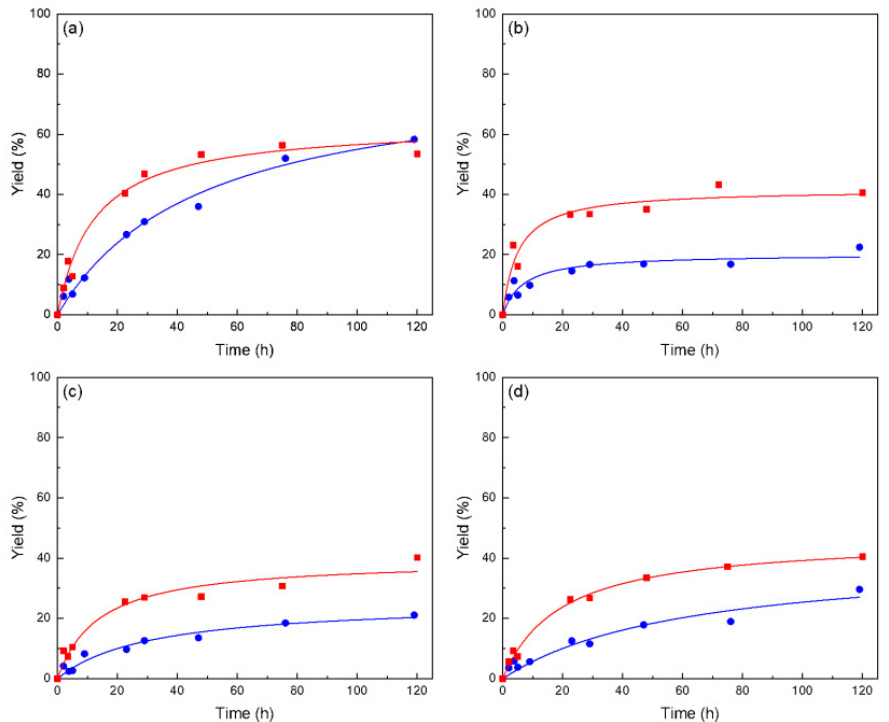
Figure 2. Synthesis of ascorbyl palmitate at biocatalyst concentrations of 60 mg ( • ) and 180 mg ( (cid:4) ) using commercial lipases: Amano PS ( a ), Lipozyme TL IM ( b ), Novozym 40086 ( c ), Lipozyme RM IM ( d ). Ascorbic acid to palmitic acid ratio 1:8, 55 ◦ C, 180 mg molecular sieve in 100% 2-methy-2-butanol. Ascorbic acid was added at times 0 h and 4 h of reaction (30 mg each